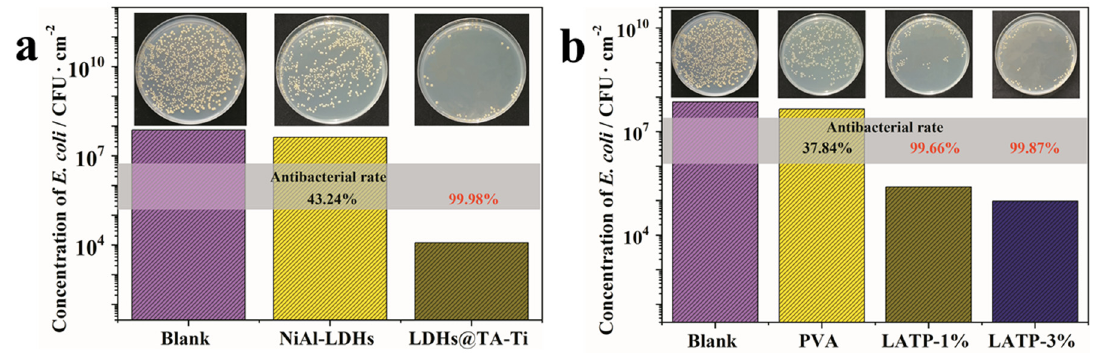
Figure 5. Antibacterial properties of ( a ) NiAl-LDHs and ( b ) LDHs@TA-Ti/PVA nanocomposites.